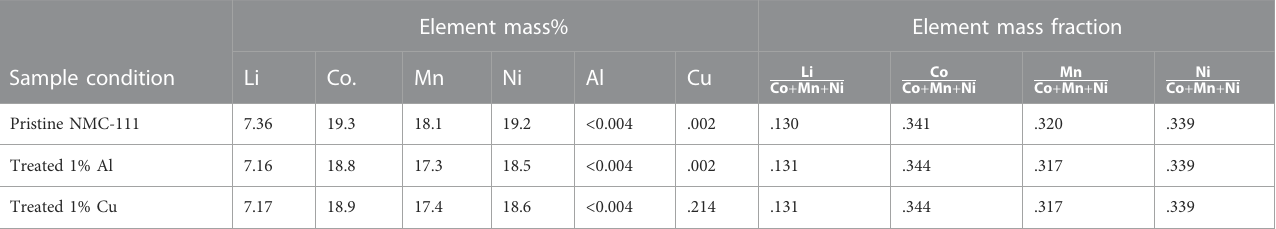
TABLE 2 ICP-MS analysis of contaminated NMC, following treatment; values are reported both as a raw mass percent (mass of metal per total sample mass) and as normalized by the total mass of transition metals (Co. + Mn +